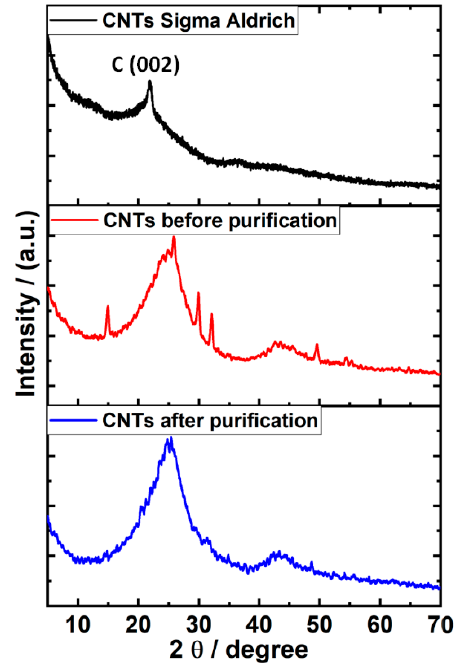
Figure 4. X-ray di ff raction (XRD) patterns of multi-walled carbon nanotubes (MWCNTs) from Aldrich Figure 4. X-ray diffraction (XRD) patterns of multi-walled carbon nanotubes (MWCNTs) from and the synthesized carbon nanotubes (CNTs) after purification with H 2 O 2 / Aldrich and the synthesized carbon nanotubes (CNTs) after purification with H 2 O 2 /acetone.